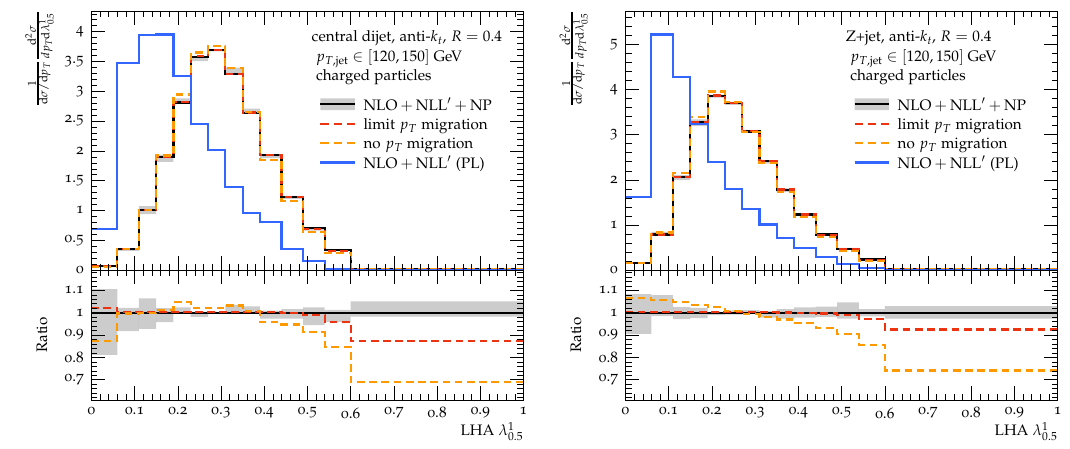
Figure 2. Effect of NP corrections on the λ 1 observable with p T, jet ∈ [120 , 150] GeV for the 0 . 5 central dijet (left) and Z +jet (right) selection. Shown are the purely perturbative result (blue), the distribution after transferring events between different observable bins within that p T, jet bin (orange), after including migration from the neighbouring p T, jet bins (red) and our final prediction at hadron level (black). The uncertainty band corresponds to variations in the UE